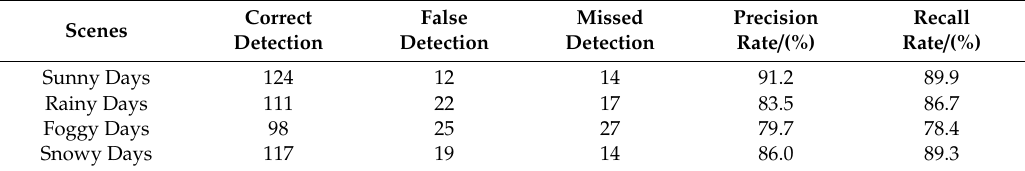
Table 4. Detection results for di ff erent weather conditions.